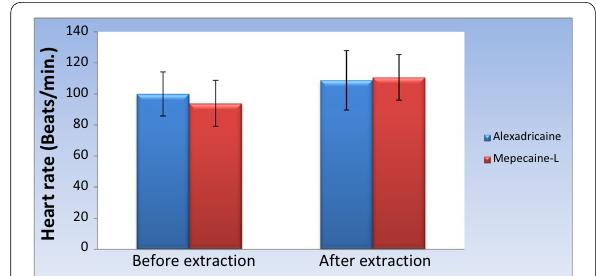
Fig. 3 Bar chart representing mean and standard deviation values for pulse rate in the two